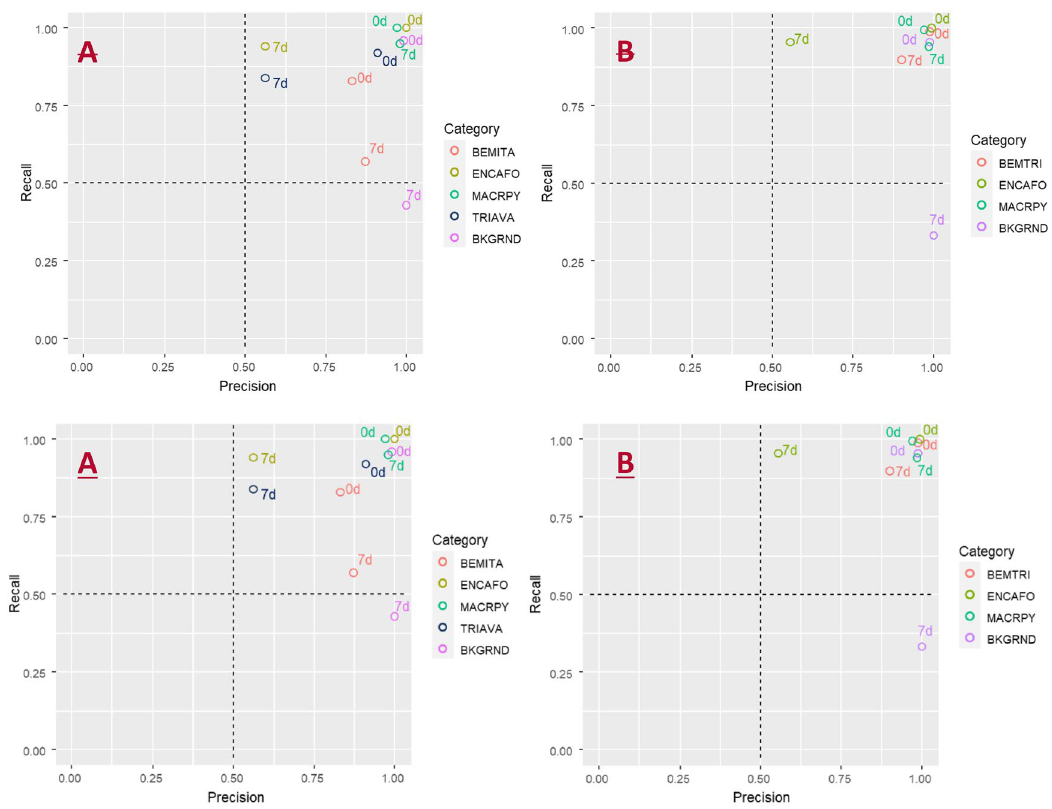
Figure 1. Recall-precision plots for ( A ) model 164 with no categorical pooling and ( B ) with categorical pooling. 7d = Lab7d dataset, 0d = Lab0d dataset, BEM-TRI = pooled class of B. tabaci and T. vaporariorum. The graphs were generated using ggplot in R 20,21